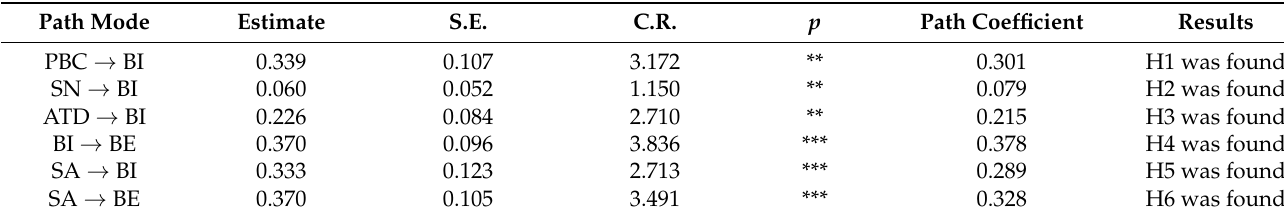
Table 7. Model path regression coefficient.